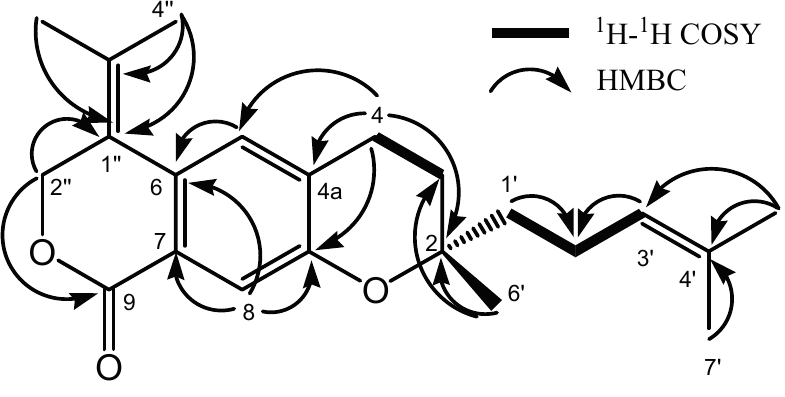
Figure 2. Selected HMBC and COSY correlations for 1